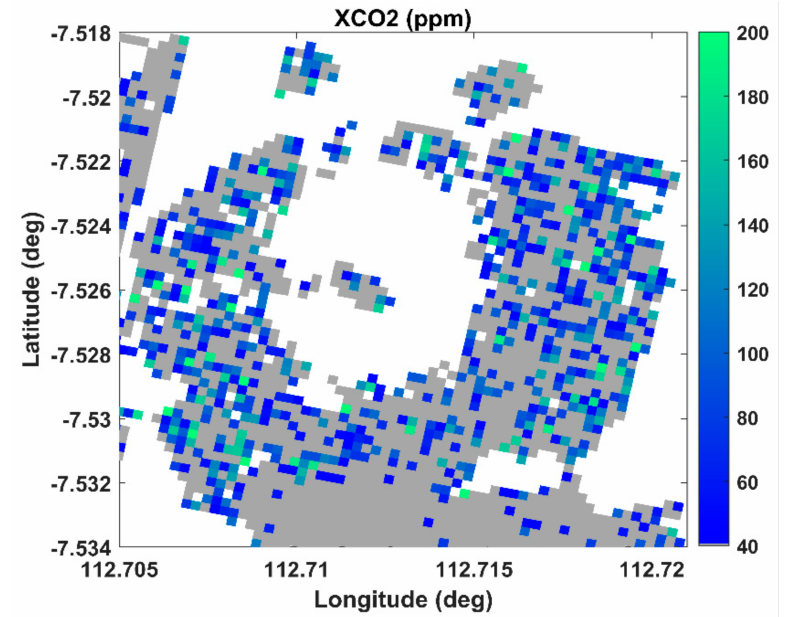
Figure 7. XCO 2 (ppm) enhancements on the LUSI test site (Indonesia); PRISMA acquisition on 14 August 2020.